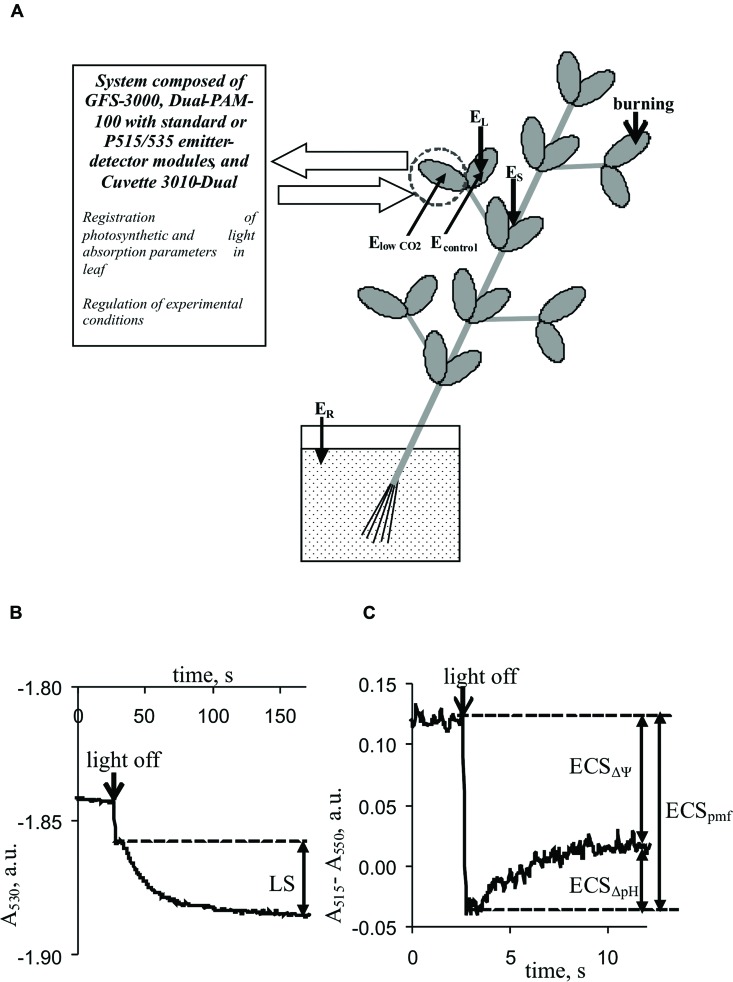
Positions of burning (flame, 3–4 s, ∼1 cm2), electrical potential monitoring, and photosynthetic and light absorption parameter measurements in plants. (A)
EL and ES, Ag+/AgCl electrodes connected to the leaf and stem, ER, reference electrode; distance between EL and ES, 3–4 cm. ElowCO2 and Econtrol, electrodes from silver wire. (B) Kinetics of leaf light absorption at 530 nm, A530. (C) Kinetics of differences between light absorption at 515 nm and absorption at 550 nm, A515–A550. LS, light scattering; ECSpmf, ECSΔΨ, and ECSΔpH represent electrochromic pigment absorbance shifts proportional to the proton motive force, transmembrane electrical potential, and proton gradient on the thylakoid membrane, respectively.